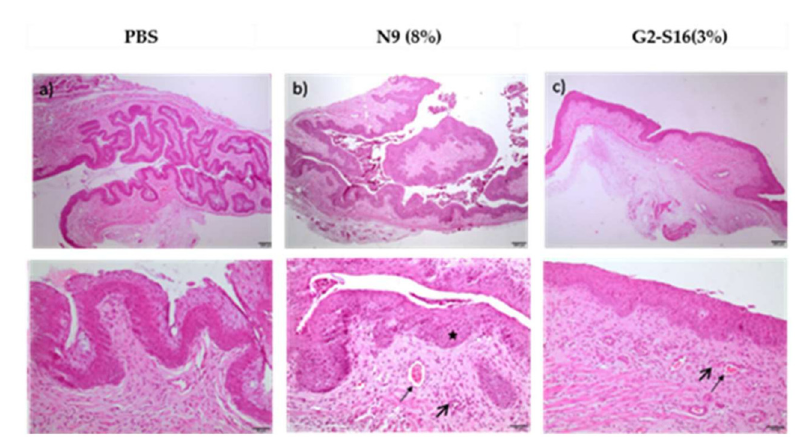
Figure 4. Histological images of CD1 mice vaginal tissue after 14-treatment with G2-S16 dendrimer. CD1 mice were treated with 14 daily applications of ( a ) PBS, ( b ) N9 or ( c ) G2-S16 dendrimer (3% w / v ). We observed different degrees of vascular congestion (small arrows), inflammatory infiltration (big arrows) and epithelial hyperplasia (star). The images on the bottom are zoom-ins at the images on the top.